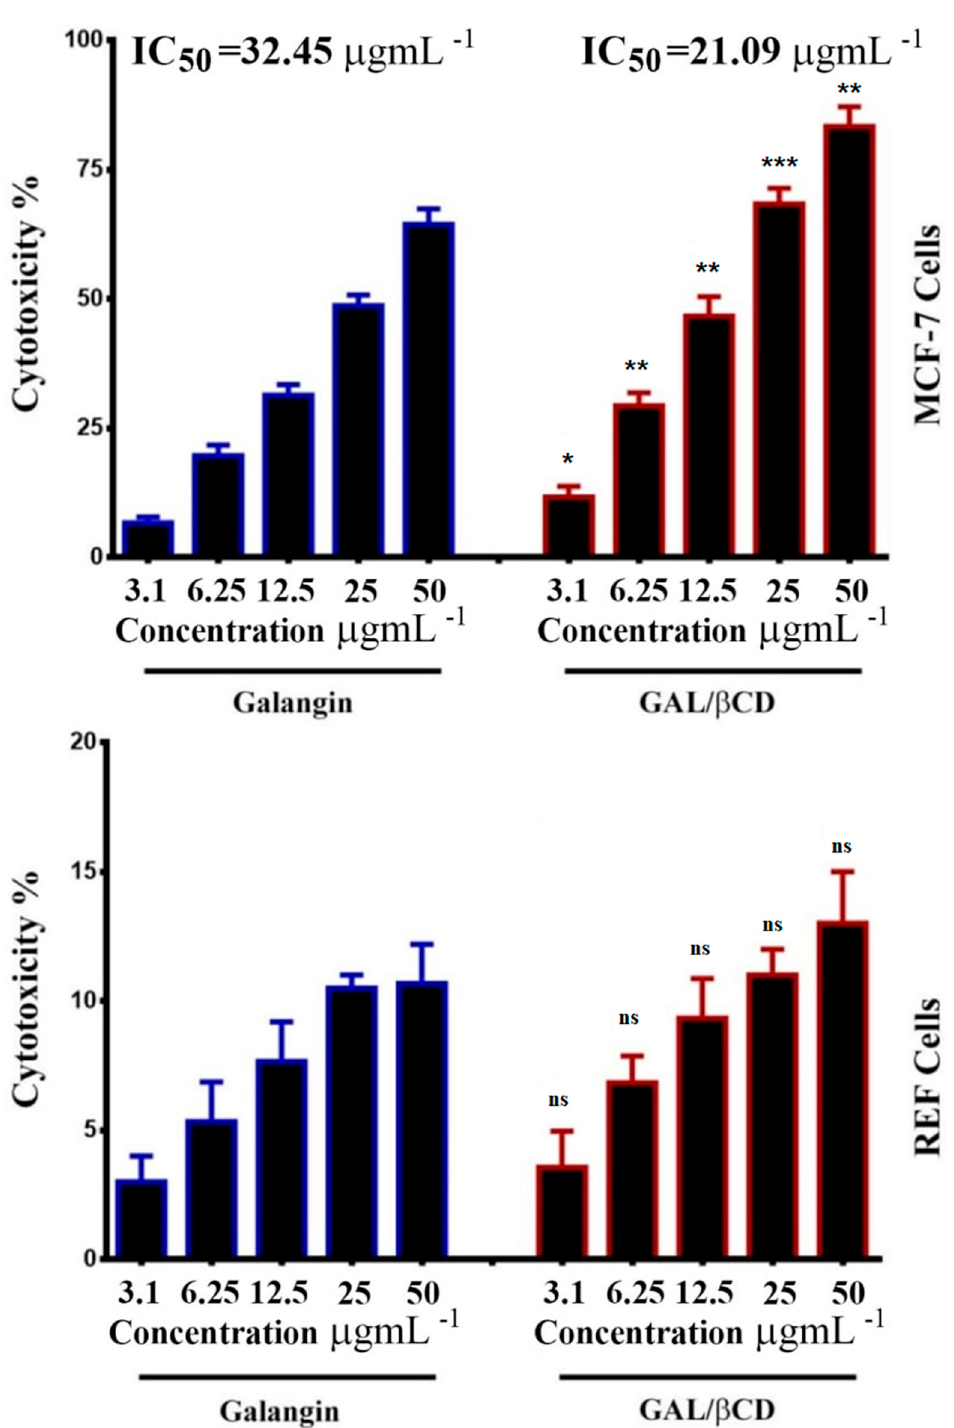
Figure 9. Growth inhibition of MCF-7 human BC and REF normal cell lines treated with different concentrations (3.1, 6.25, 12.5, 25 and 50 µ g mL − 1 ) of galangin and GAL/ β -CD. * p ≤ 0.05, ** p ≤ 0.01, concentrations (3.1, 6.25, 12.5, 25 and 50 µg mL − 1 ) of galangin and GAL/ β -CD. * p ≤ 0.05, ** p ≤ 0.01, *** p ≤ 0.001. ns, *** p ≤ 0.001. ns, non-significant.